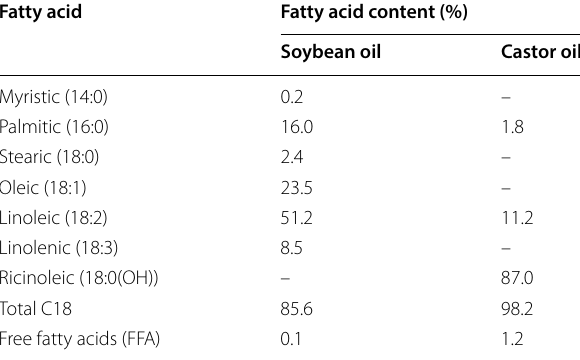
Table 1 Typical fatty acid composition (%) of soybean oil and castor oil (Meneghetti et al. 2006,